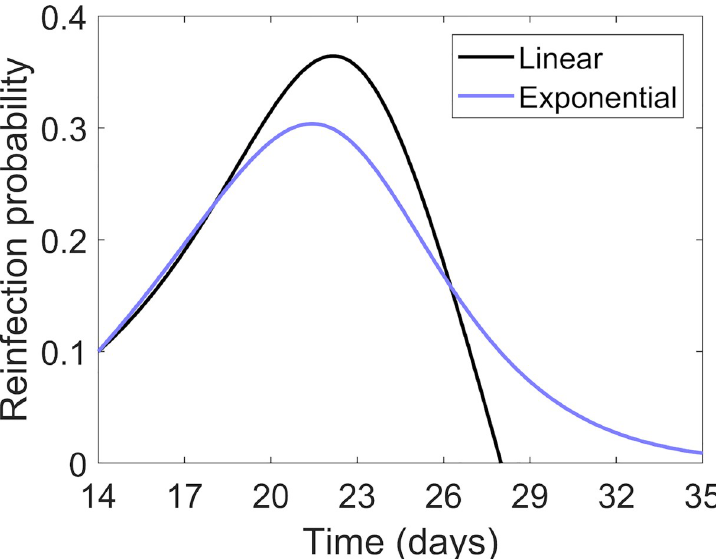
Fig 5. Reinfection probability. Reinfection probability for a lesion with r max = 1 mm and ρ = 0.10 day -1 . In black, original Bubble model [14]; in blue, the updated model considering an exponential decrease during the control phase. The area under the two curves is equivalent.